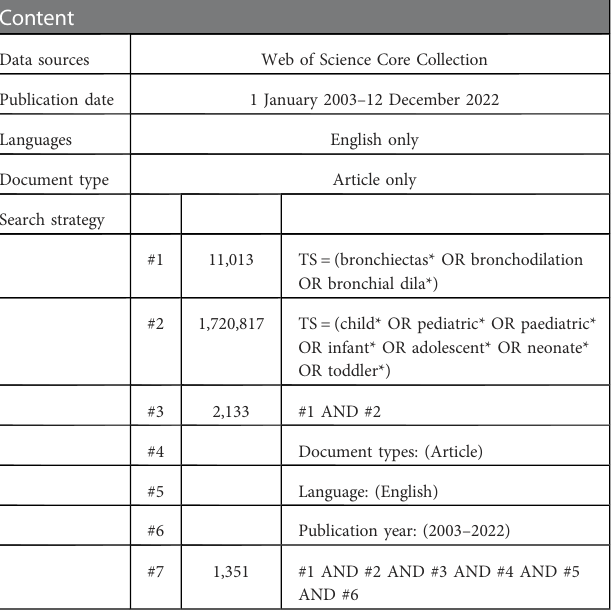
TABLE 1 Data sources and fl ow of the retrieval